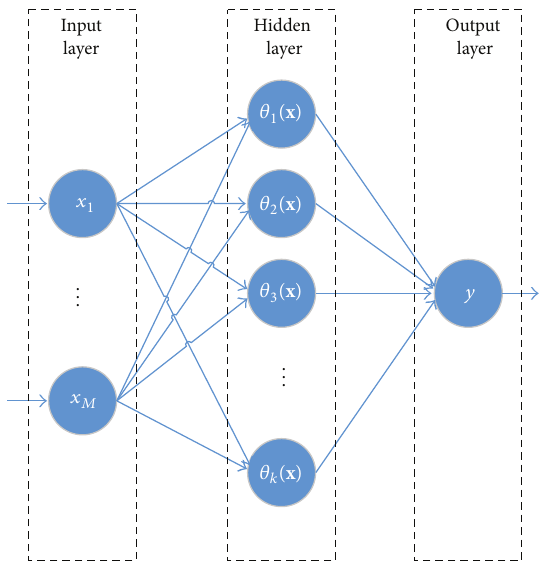
Figure 1: The structure of radial basis function neural network